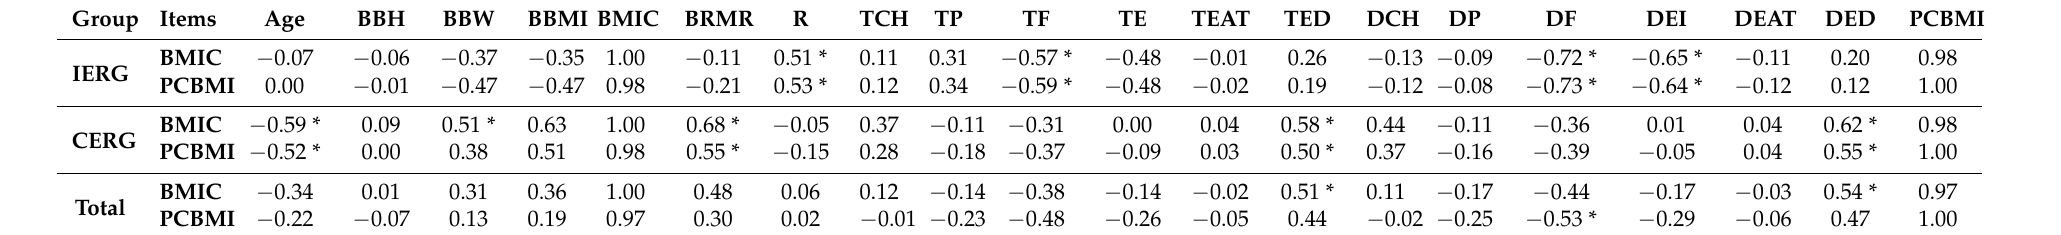
Table 5. Correlation analysis between the effect and the variables in the whole plan.